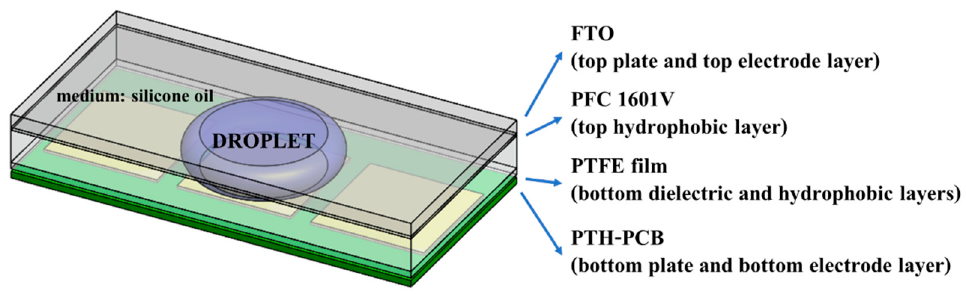
Figure 10. Components of closed EWOD device.